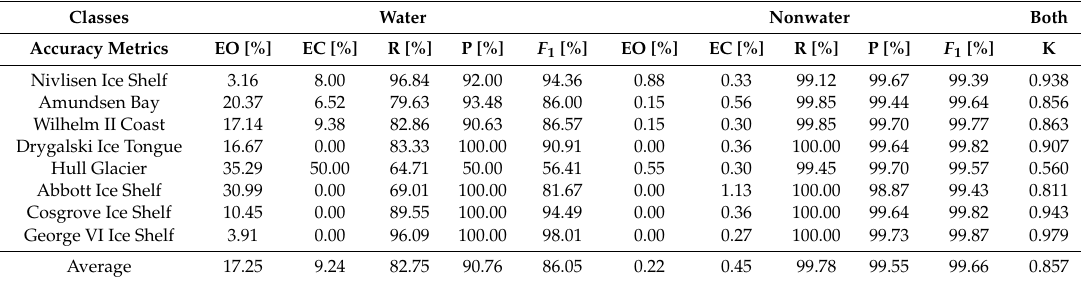
Table 6. Results of the accuracy assessment for the Sentinel-2 test scenes. For each test scene, the columns present the Error of Omission (EO), the Error of Commission (EC), the Recall (R), the Precision (P), the F-measure ( F 1 ), the Kappa statistics (K) as well as their average